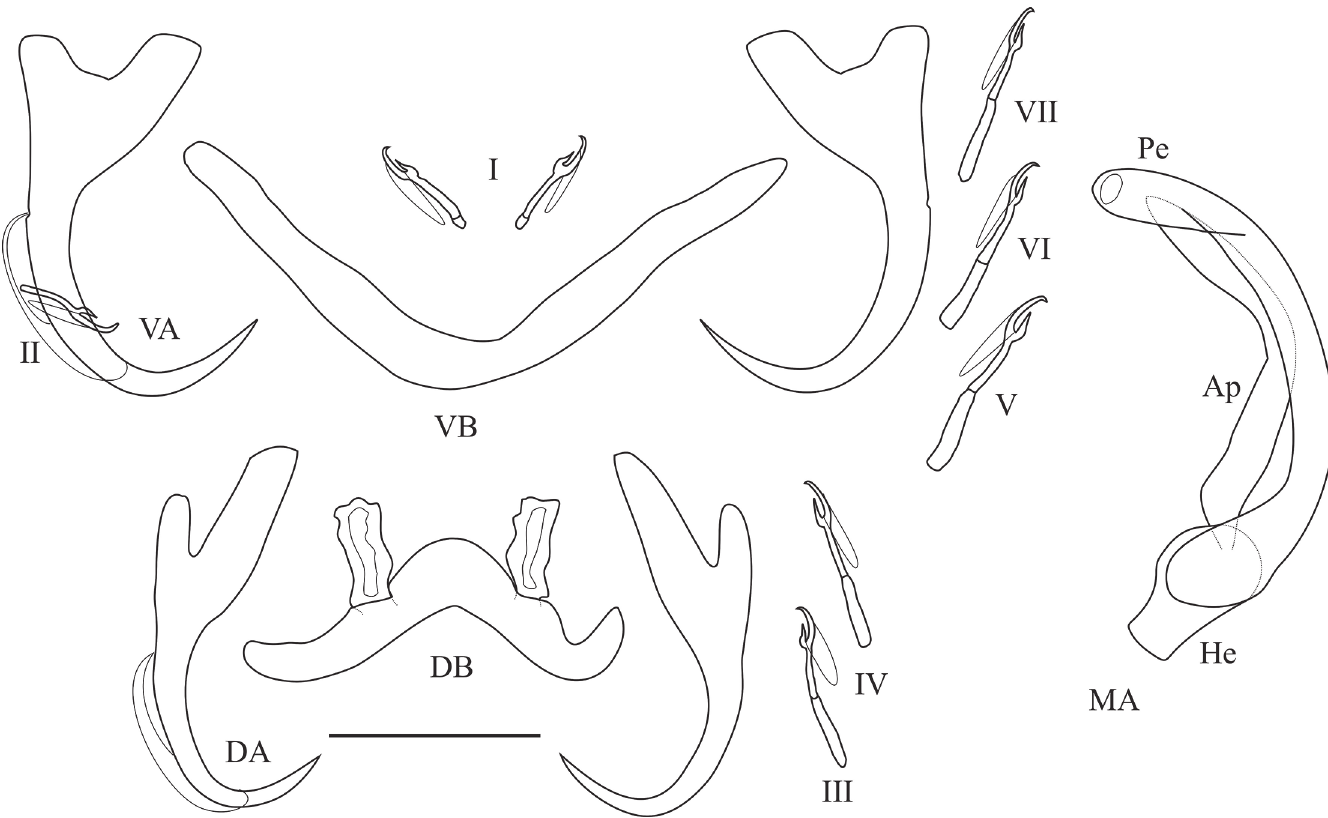
Fig 13. Haptoral and genital hard parts of Cichlidogyrus franswittei sp. nov. (Ap) accessory piece (DB) dorsal transverse bar, (DA) dorsal anchor, (He) heel, (MA) male apparatus, (Pe) penis, (VB) = ventral transverse bar, (VA) ventral anchor, (I) to (VII) uncinuli, scale bar = 20 µ